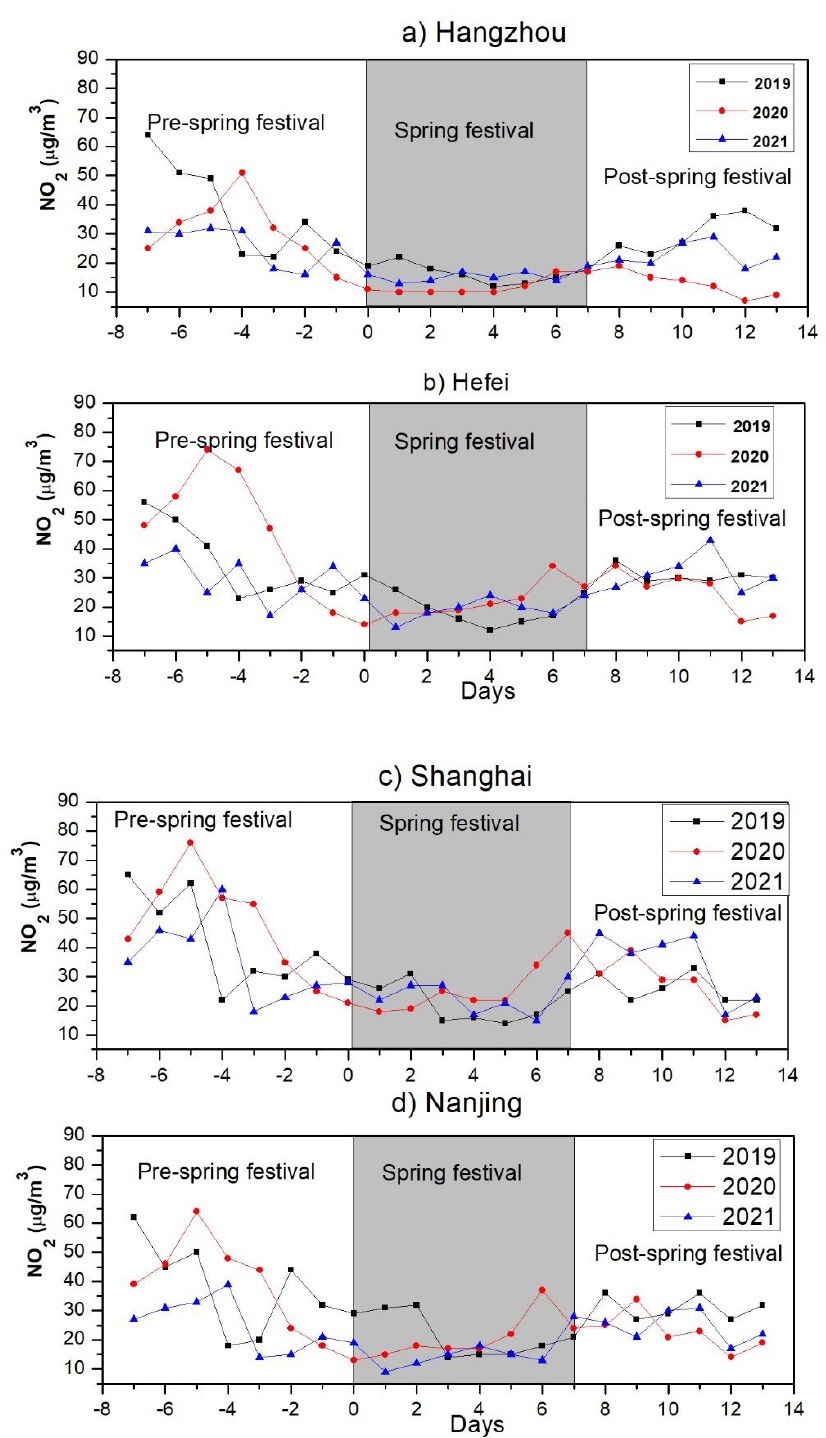
Figure 5. Impact of Spring Festival holidays on the NO 2 concentration over YRD region.